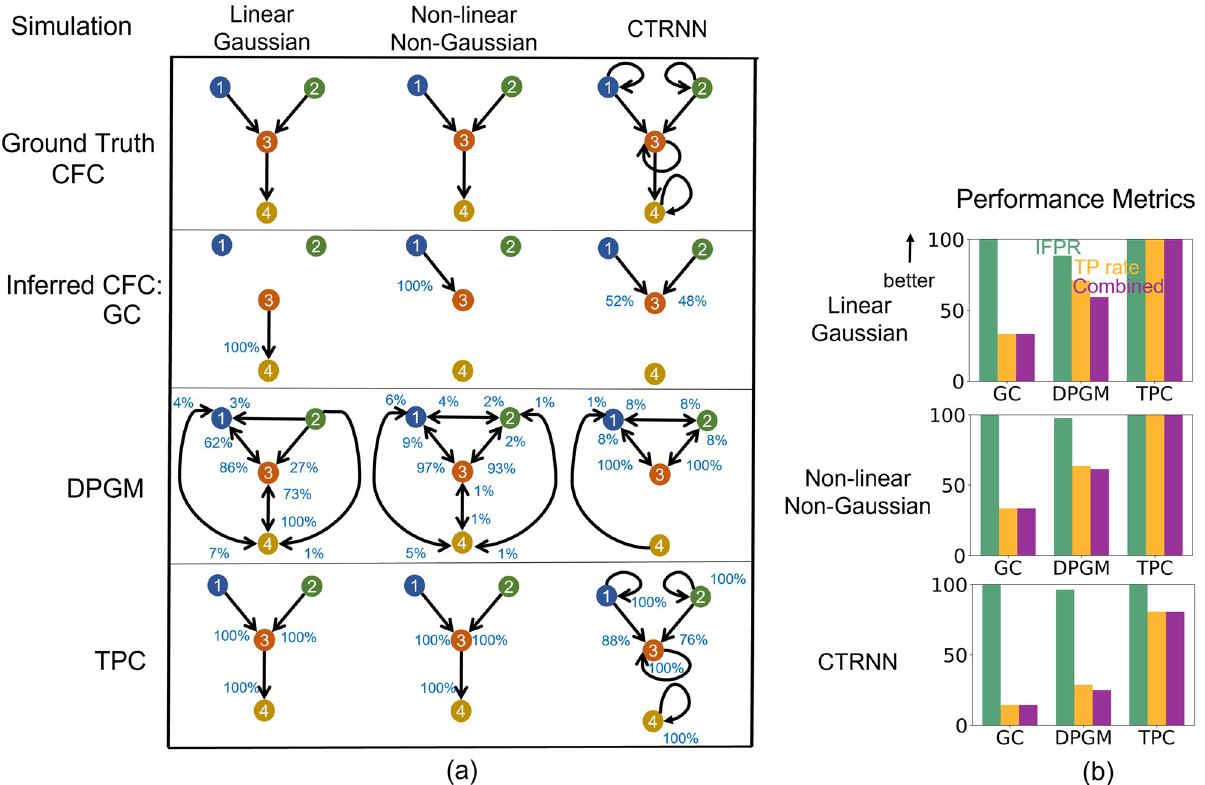
Fig 3. Comparative study of CFC inference. (a) CFC inference by GC, DPGM, and TPC, is compared on three examples of motifs and simulation paradigms; from left to right: Linear Gaussian, Non-linear Non-Gaussian, CTRNN. Table: 4-neurons motifs that define the Ground Truth CFC (row 1) are depicted along with inferred CFC over several simulation instances according to the three different methods (row 2–4). Each inferred CFC has an edge v ! w that corresponds to an edge detected in any of the inference instances. The percentage (blue) next to each edge indicates the number of times the edge was detected out of all instances. (b) IFPR (green), TP rate (orange) and Combined Score (purple) of each method are shown for each